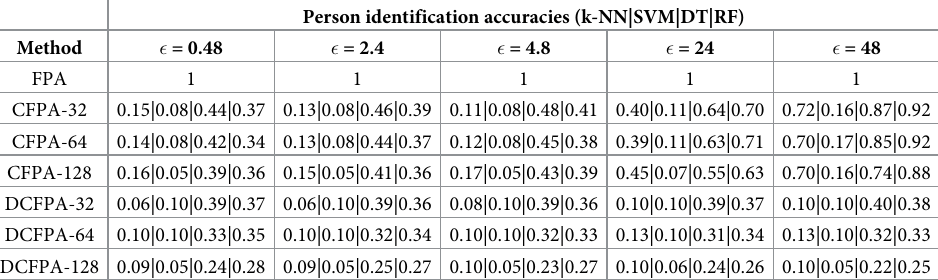
Table 3. Person identification accuracies in the MPIIDPEye dataset using differentially private eye movement fea- tures with majority